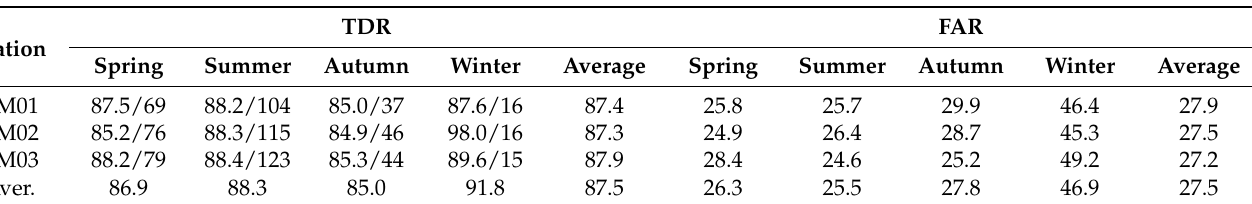
Table 2. Statistical results of TDRs and FARs of the linear method-based rainfall forecast model in different seasons at the three stations (%/number of rainfalls).